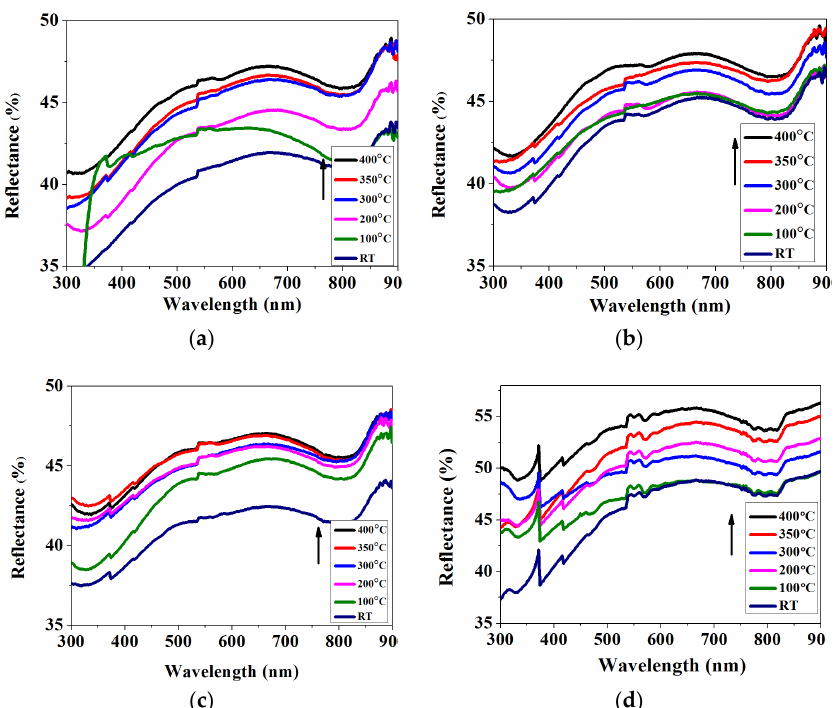
Figure 5. Reflectance of Mo thin films deposited at ( a ) different substrate temperatures; ( b ) different annealing temperatures; ( c ) different substrate temperatures and 300 °C annealing temperature; and ( d ) different substrate temperatures and 400 °C annealing, respectively.